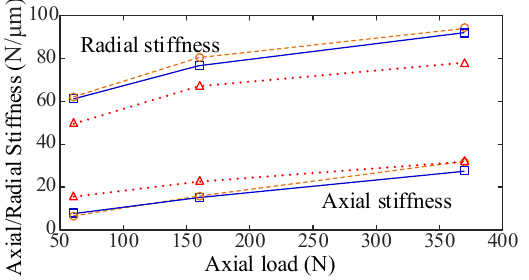
Figure 6. Comparison of the dynamic stiffness (1000 rpm) obtained by the proposed model ( — □ — ) to the FEM results ( … △ … ) of Guo [37] and the experiment results ( -- ○ -- ) of Kraus [41].